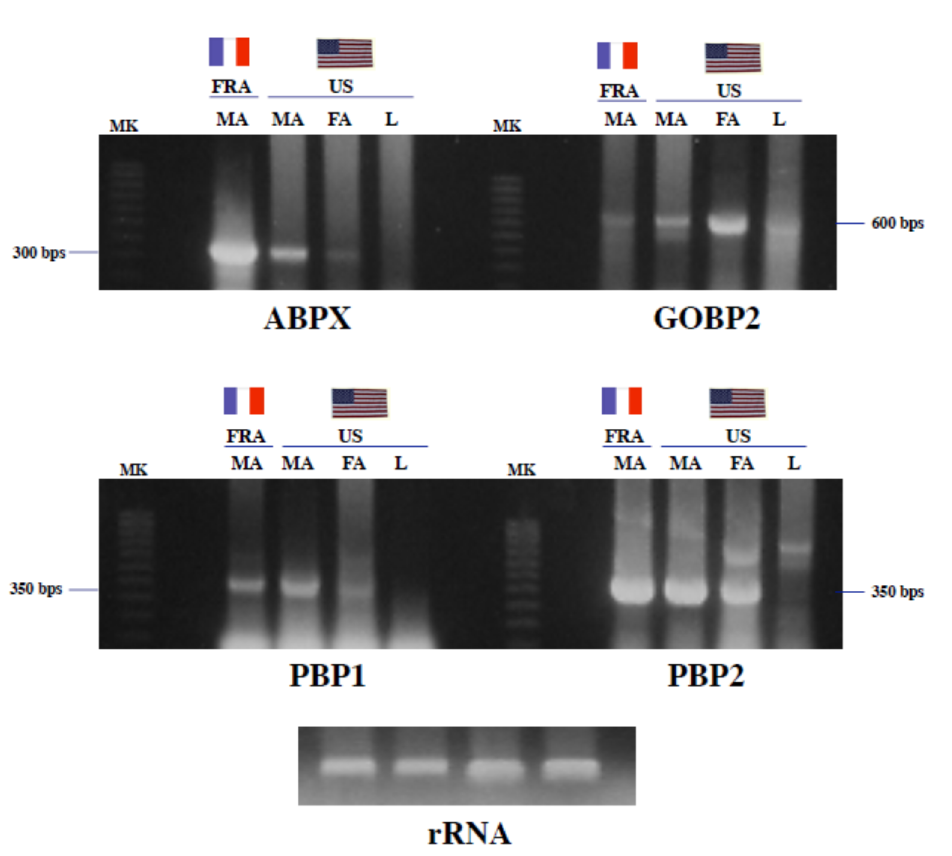
Figure 3. Interpopulational variations of odor binding protein-mRNA levels in A. ipsilon . Titanium one-step reverse transcription polymerase chain reaction analysis of total RNA (500 ng per lane) from the male antennae of the American (US) and French (FRA) populations of A. ipsilon . Focus was given to males since the antennal binding X (ABPX) protein was remarkably abundant in males from the French population. MK: molecular weight markers (100 bps), MA: male antennae, FA: female antennae, L: legs; total RNA from legs was used as a tissue control. For RNA control, 5 µ g of each total RNA sample was analyzed on a formaldehyde agarose gel. RT-PCR products of expected size (between 300 and 600 bps) were amplified using pairwise oligonucleotide primer combinations specific to ABPX1, GOBP2, PBP1 and PBP2, respectively. PBP1 and PBP2 are used as housekeeping control genes that are expected to equally expressed across the populations. Interpopulational di ff erences in RNA levels were noticed in ABPX and GOBP2 expression, but not in the expression of PBP1 and